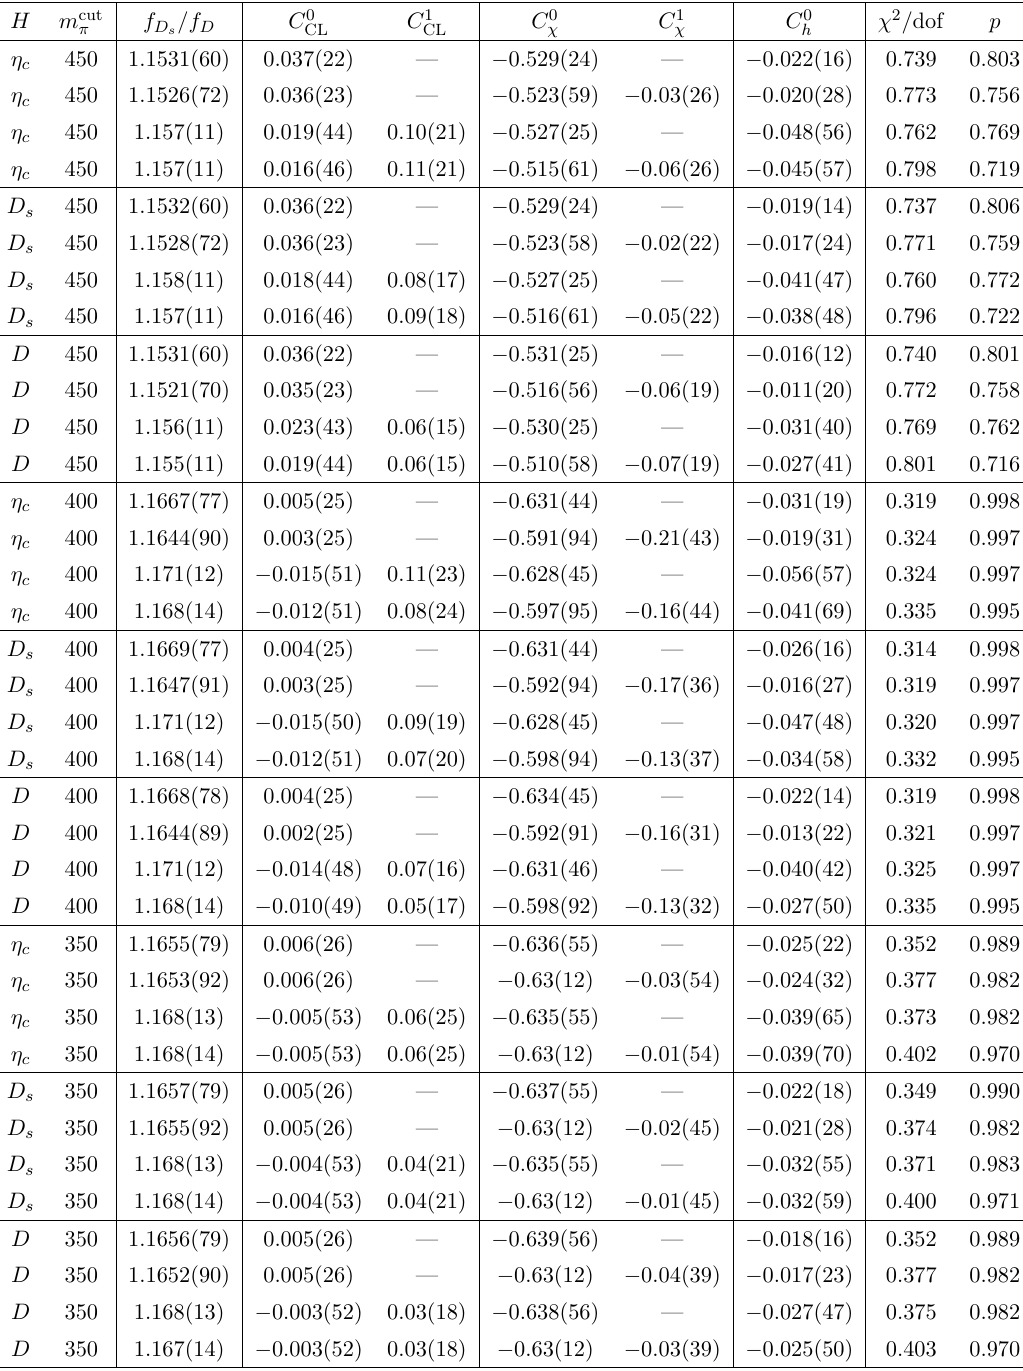
Table 14 . Fit results of the di(cid:11)erent versions of the global (cid:12)t ansatz (3.6) for the observable f D =f D s